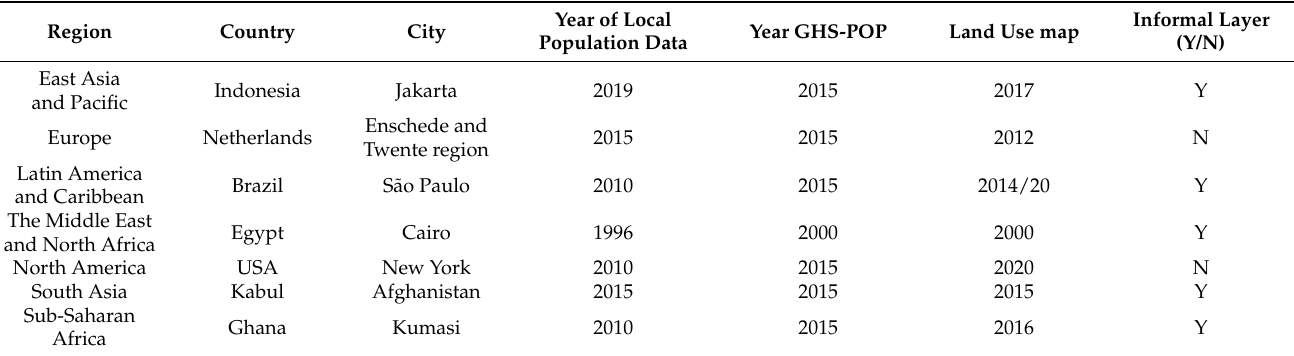
Table 5. Selected case cities by world